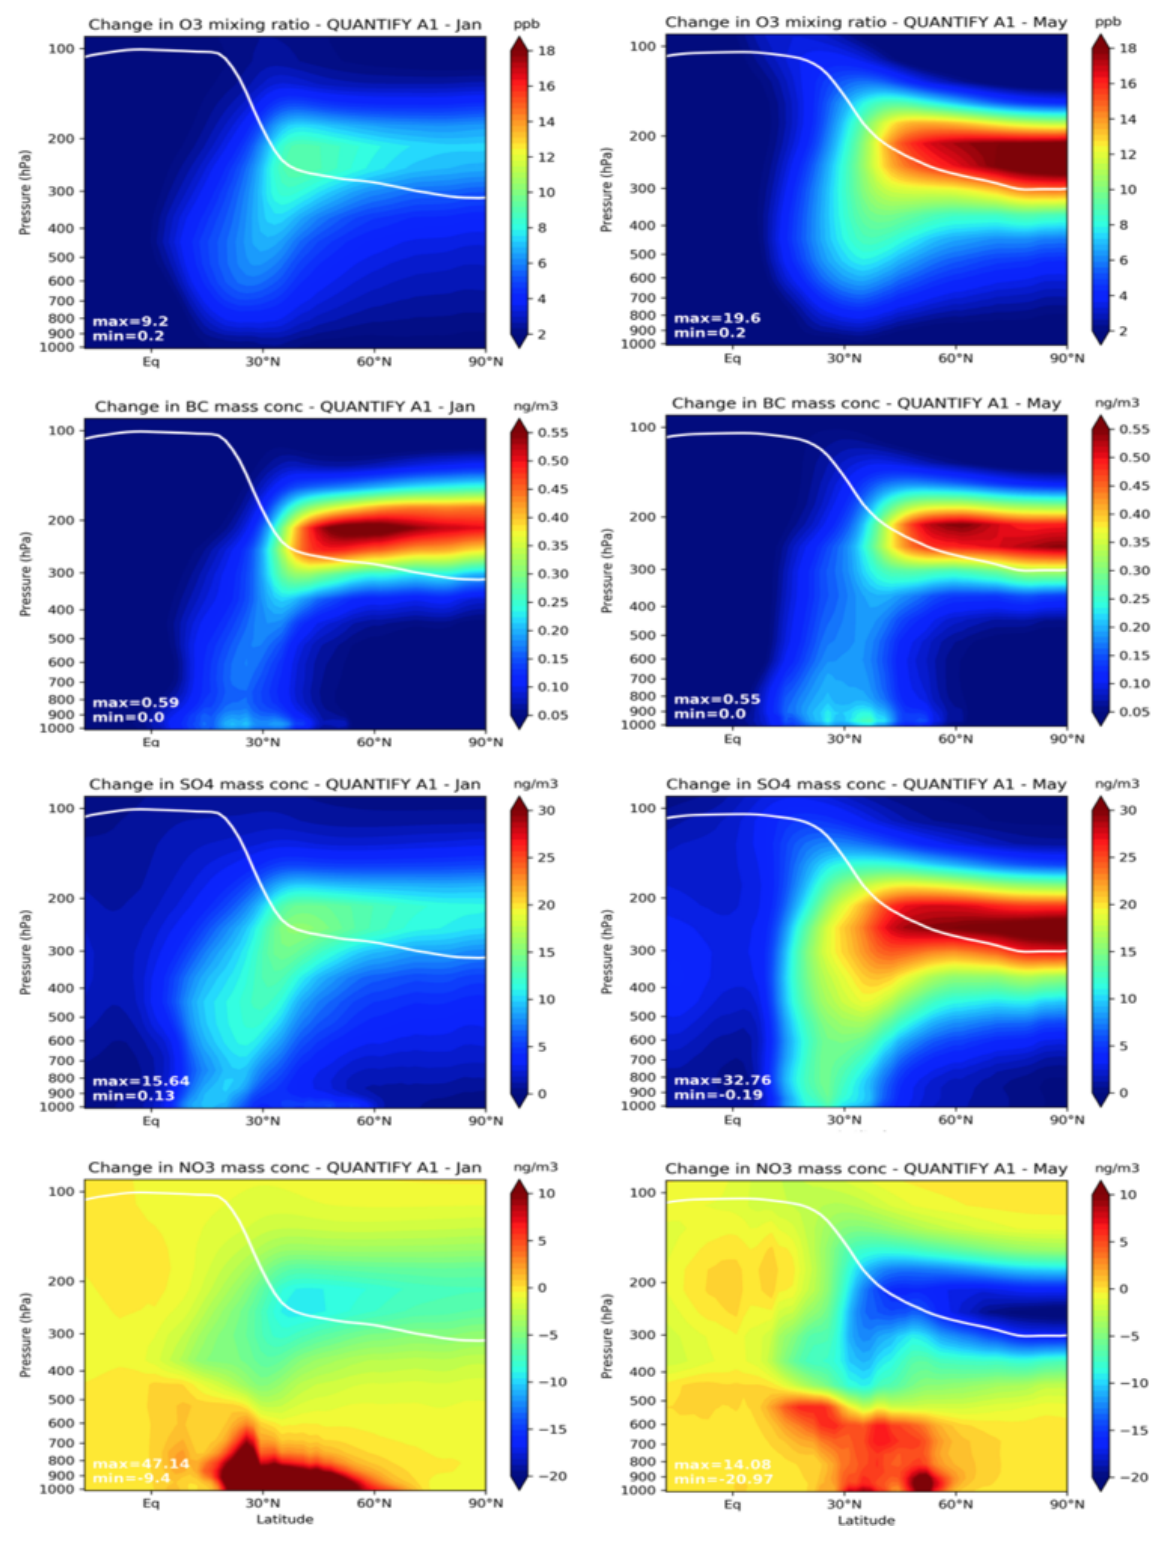
Figure 9. Zonal mean perturbations due to aircraft emissions for the months of January (left) and May (right) for O 3 (ppbv), BC (ngm − 3 ), SO 4 (ngm − 3 ), and NO 3 (ngm − 3 ), averaged for the future scenario QUANTIFY A1 2050. The solid line represents the tropopause